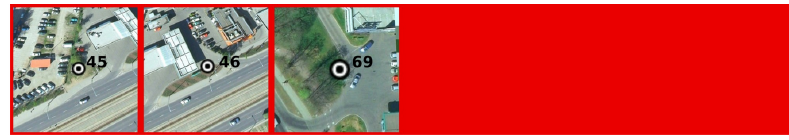
Figure A1. GWT maximum outliers